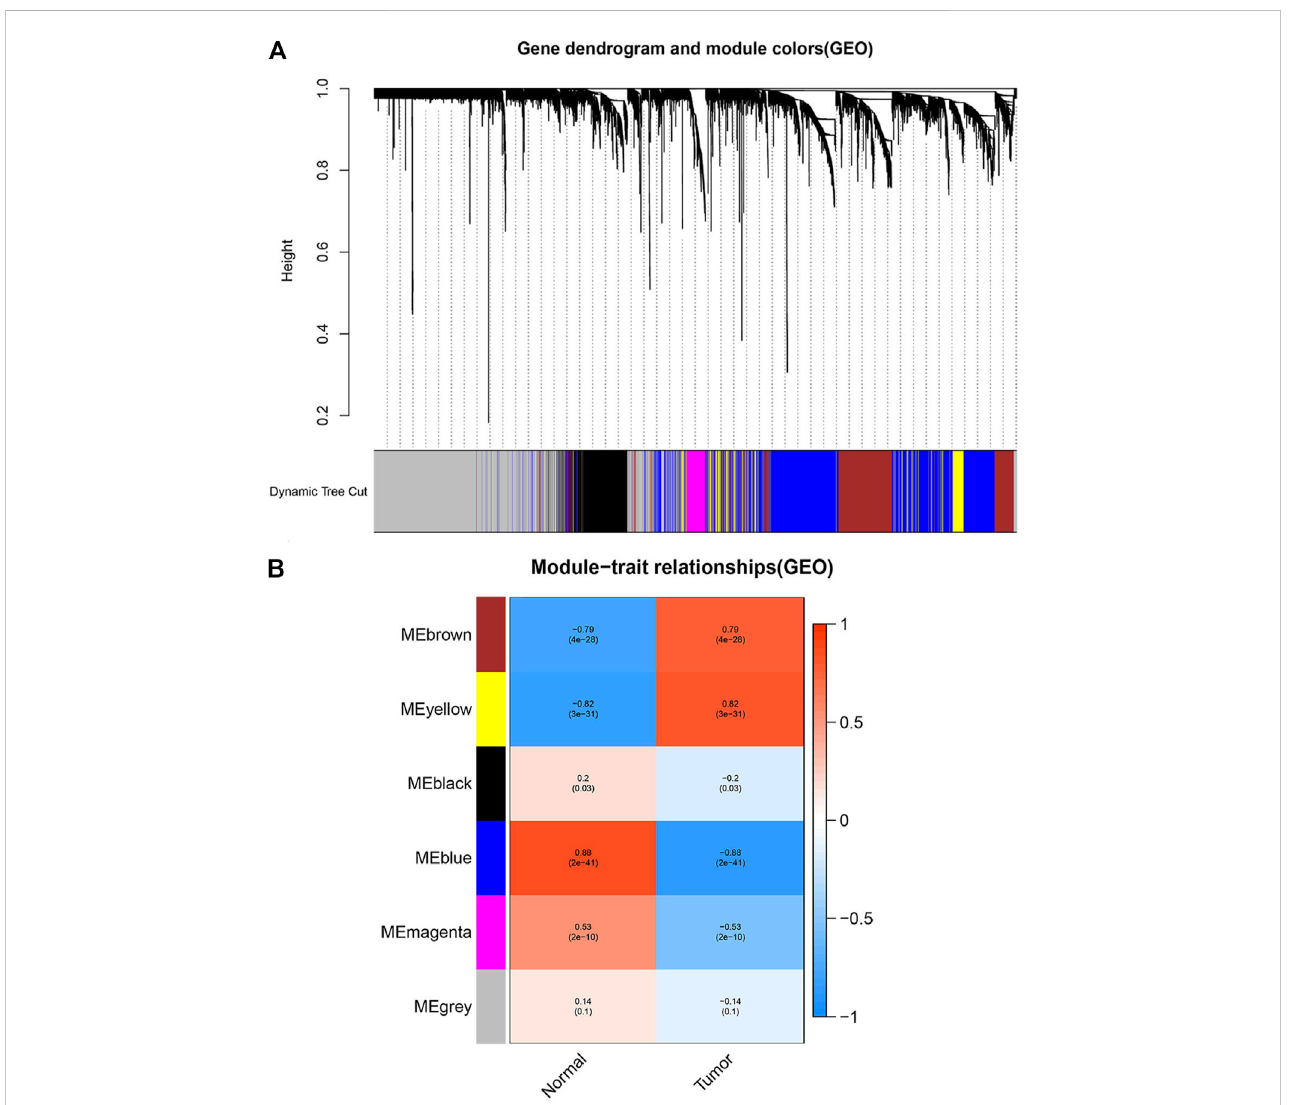
FIGURE 2 Screen the modules correlated with the clinical information from the GSE46699 dataset. (A) The hierarchical clustering of genes based on the 1-TOM matrix is used to sort the clustering tree of co-expression network modules. Mark each module with a different color. (B) Module-trait relationship in GSE46699.Eachrowcorrespondstoacolormodule,andeachcolumncorrespondstothetumorandnormal.Eachcellconsistsofthecorresponding p -value and